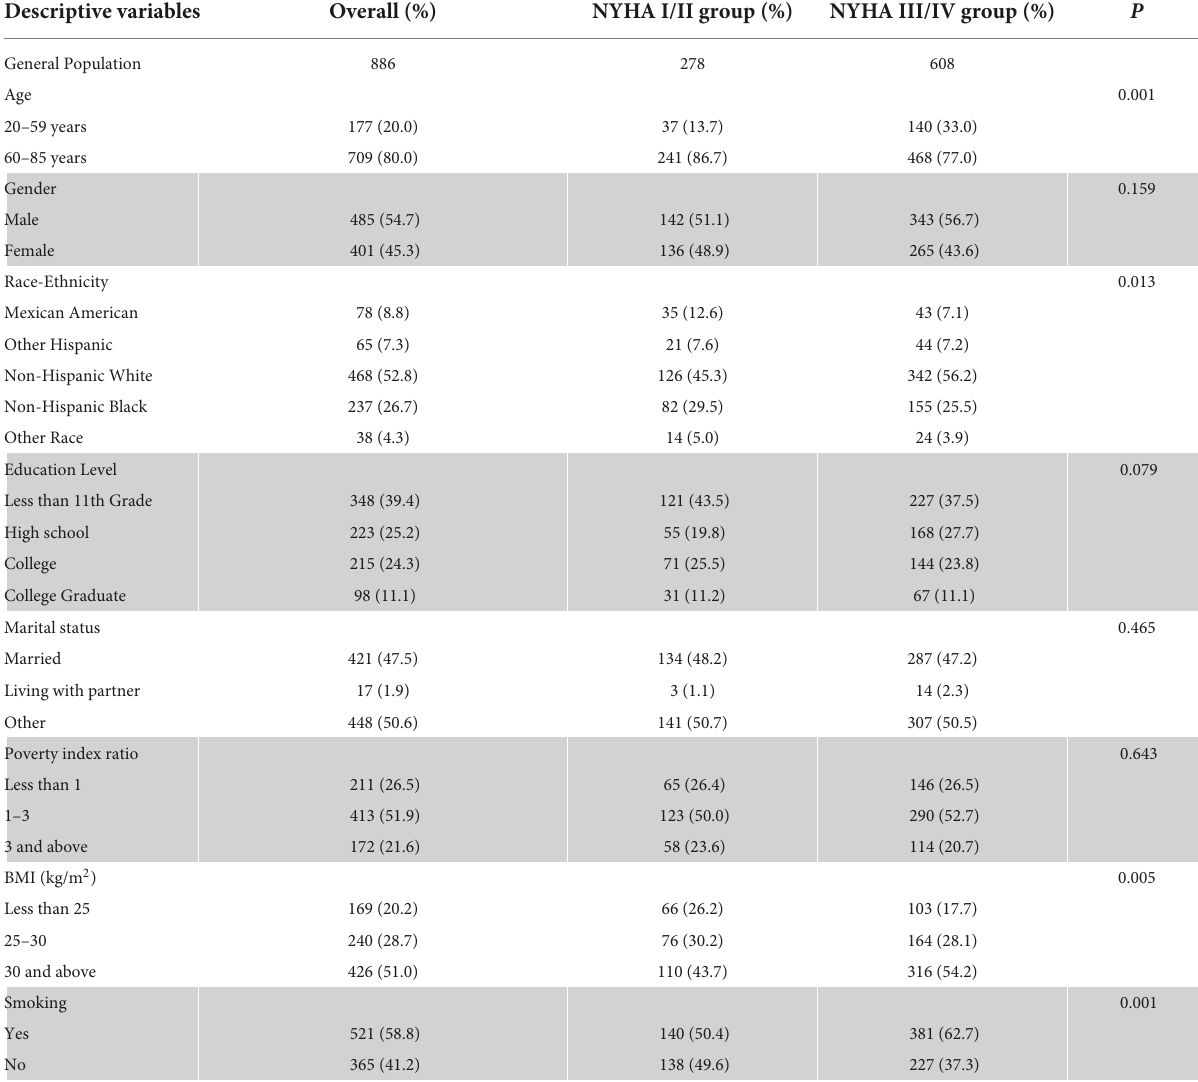
TABLE 1 Demographic characteristics of heart failure participants ( N = 886, weighted count 3,959,970). Descriptive